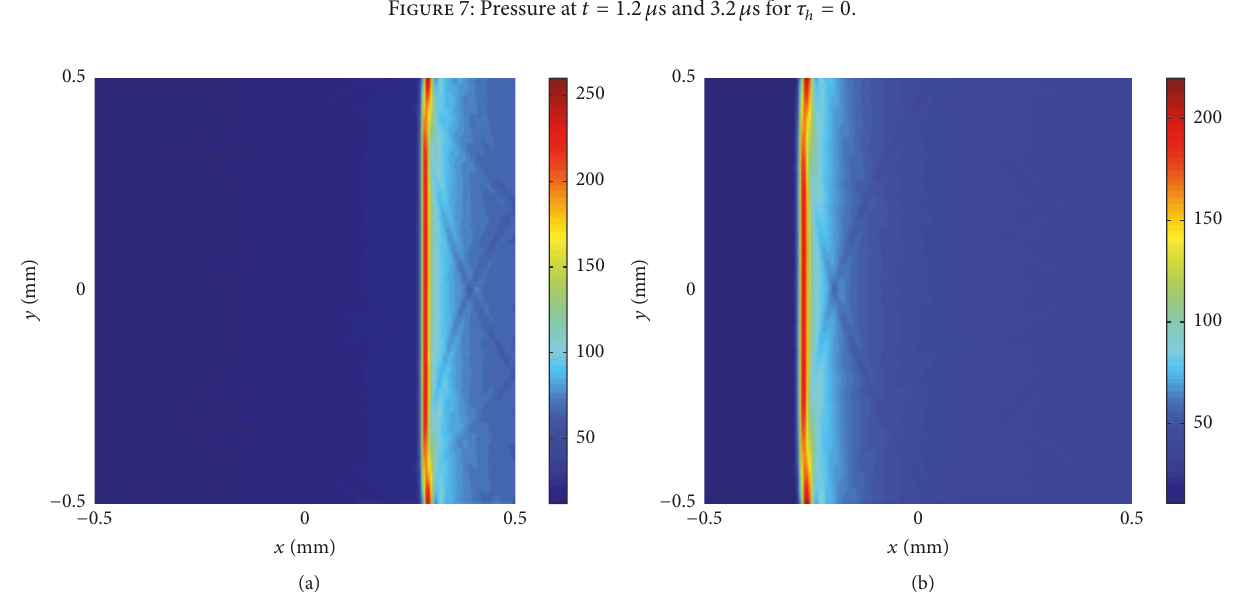
Figure 8: Pressure at 𝑡 = 4.4 𝜇 s and 6.4 𝜇 s for 𝜏 ℎ = 0